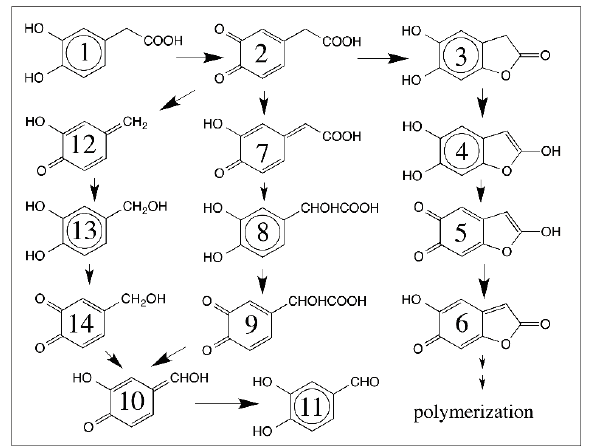
Figure 14. Multiple routes for the oxidative transformation of 3,4-dihydroxyphenylacetic acid. 3,4 - Dihydroxyphenylacetic acid ( 1 ) is readily oxidized by tyrosinase to its quinone ( 2 ). This